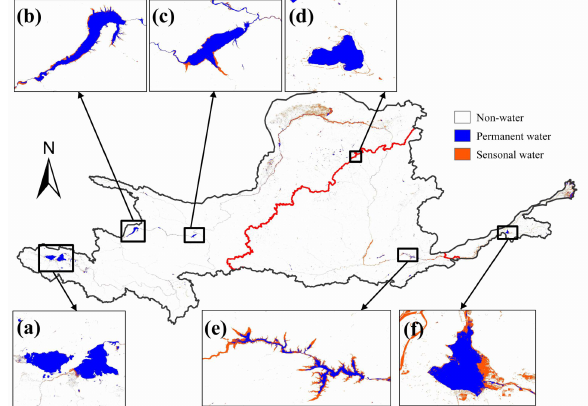
Figure 7. Spatial distribution of surface water in the YRB from 2000 to 2020. In order to view the details more obviously, some local typical water bodies are shown with enlargement. (a): Zhaling Lake and Eling Lake; (b): Longyang Reservoir; (c): Liujia Reservoir; (d): Hongjiannao Lake; (e): Xiaolangdi Reservoir; (f): Dongping Lake.